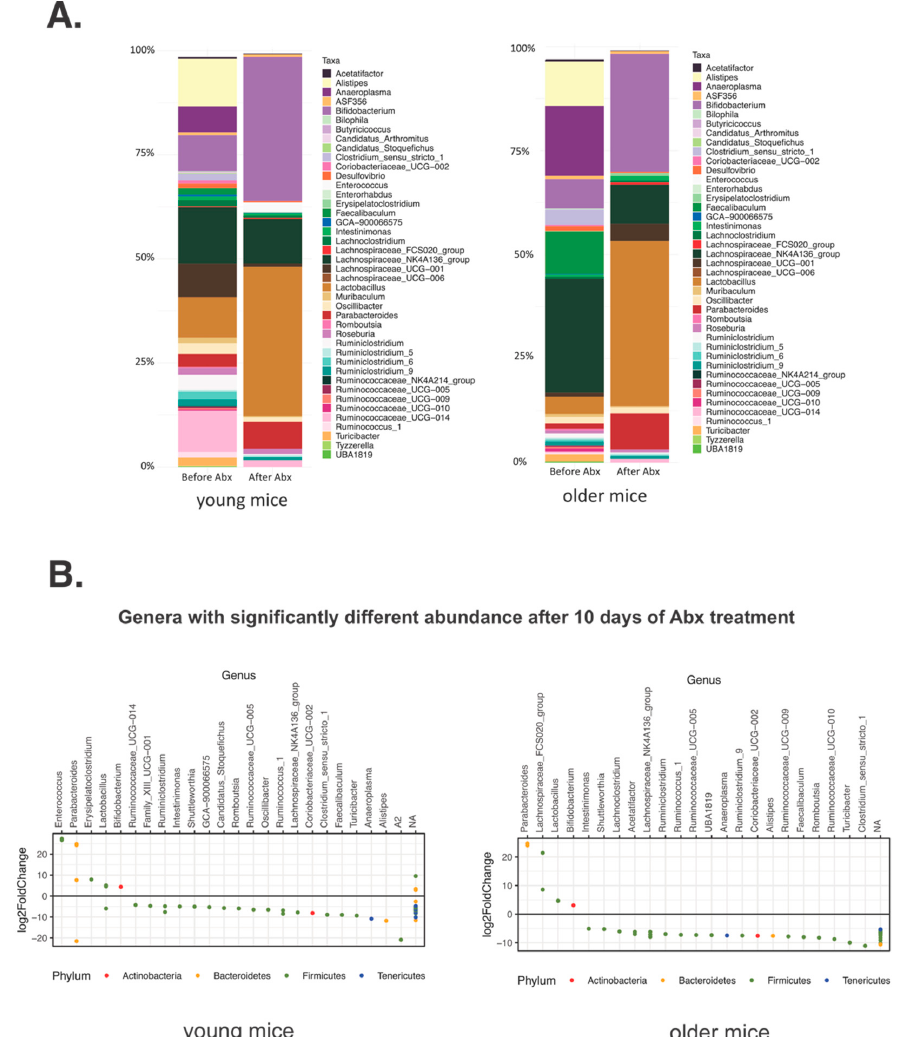
Figure 2. Changes in taxonomical composition after the 10-day treatment with Abx cocktail at genus level in ( A ) young and older mice. Genera with relative abundance lower than 0.5% were removed from the graphs for clarity. ( B ) The genus level differential abundance analysis with DESeq2 showing changes in taxa abundance in young (left panel) and older (right panel) mice after the Abx treatment. Each dot represents the log2 fold change between “before” and “after” the antibiotic treatment.